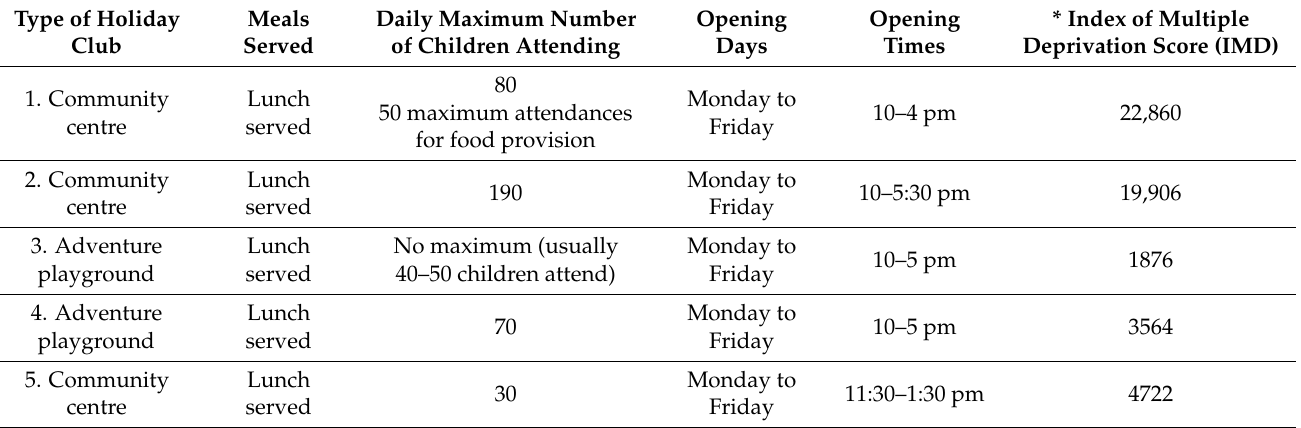
Table 1. Operational information on the holiday clubs involved in the current study. * Information from the English Index of Multiple Deprivation 2015, which ranks every small area in England from 1 (most deprived area) to 32,844 (least deprived area) based on a range of deprivation indicators including income, employment, health, education, crime, and living